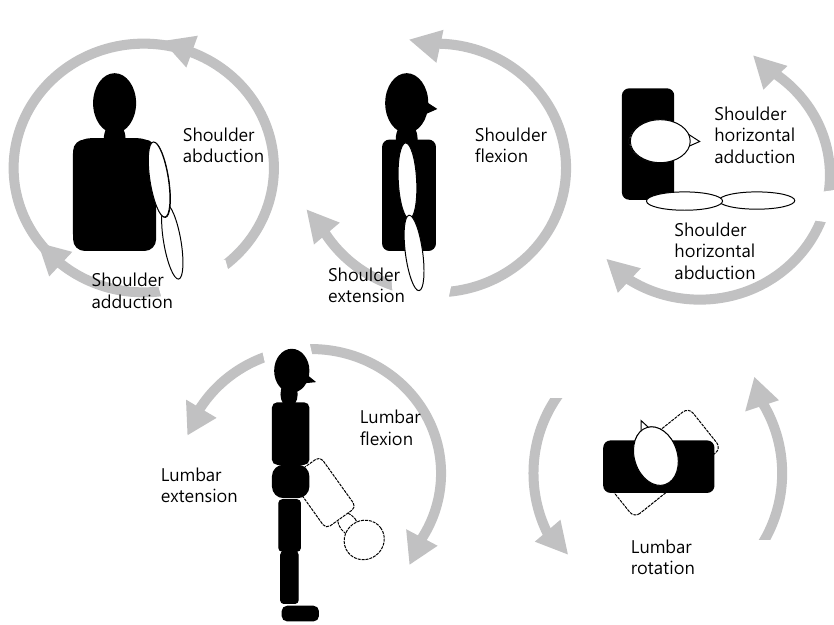
Fig. 2 Experimental posture of range of motion. The postures presented above are starting postures of shoulder adduction, abduction, flexion, extension, horizontal adduction, horizontal abduction, and lumbar flexion, extension, and rotation. Participants moved their arms or upper body in the direction of the arrow, and the maximum moved angles of their shoulders or upper body were measured as the range of